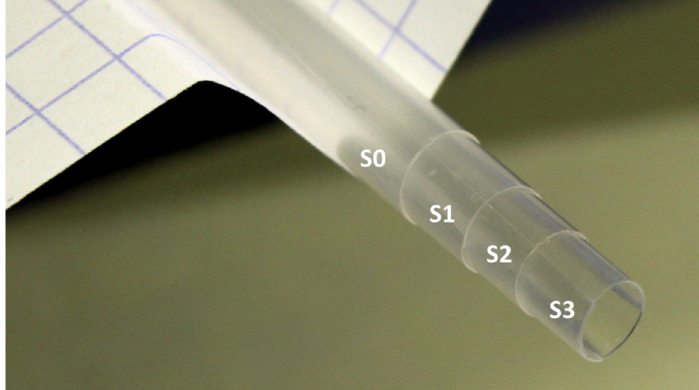
Figure 5. A complete set of three cut straws (S1, S2 and S3) inserted into the original straw S0. To nest in S0, the next straws have to progressively reduce their diameter by adequate curling.